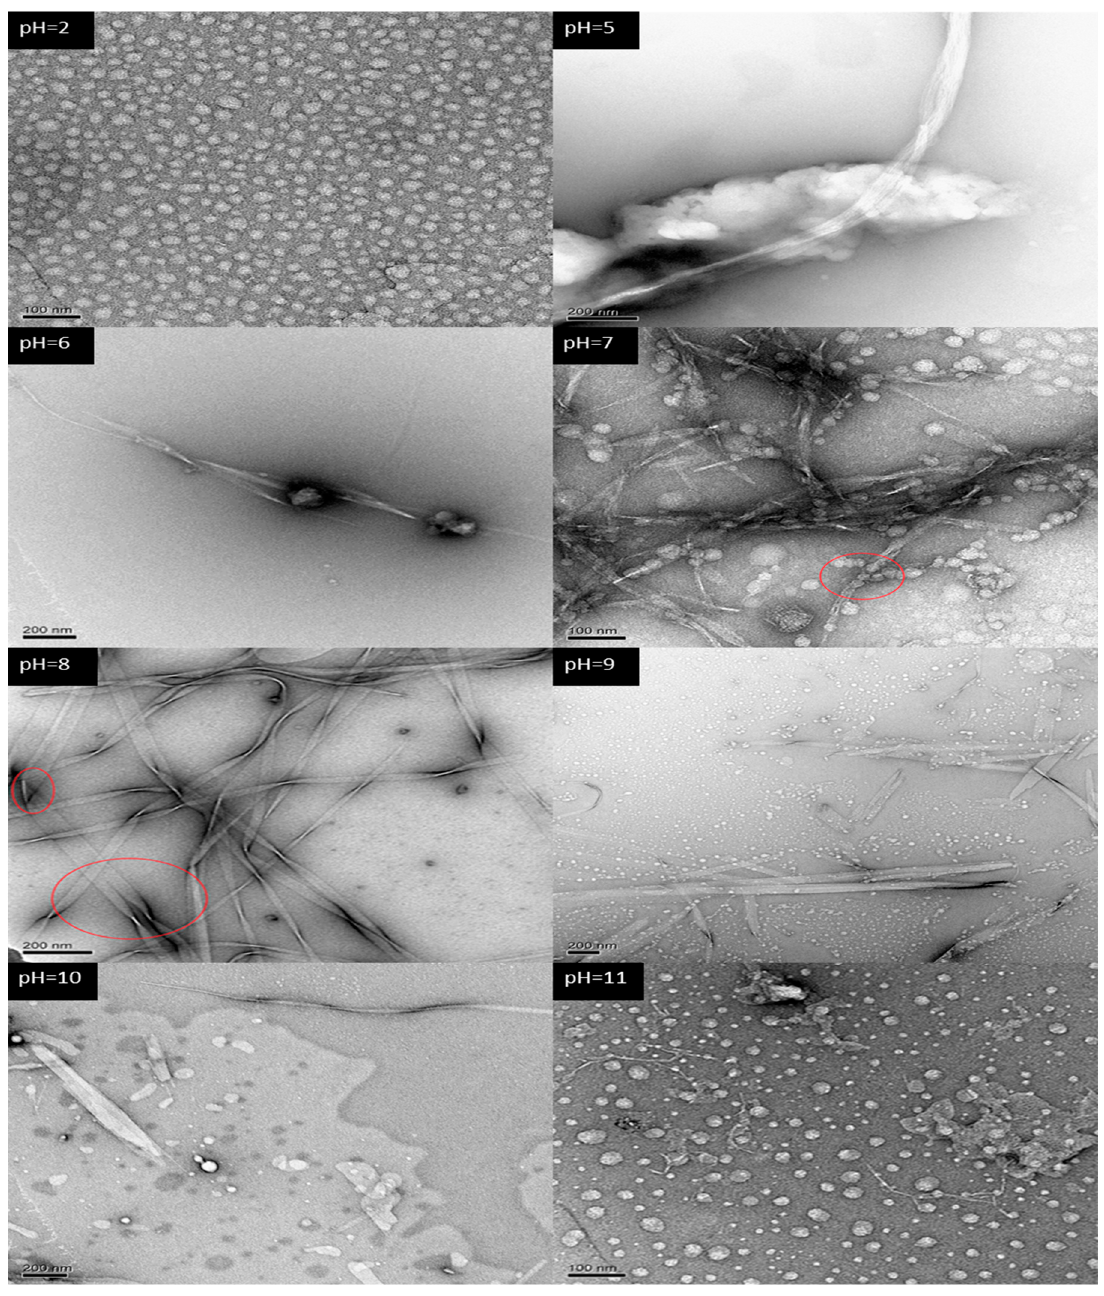
Figure 2. TEM morphologies of the self-assembled structures of A 6 K at different pH. The label in the upper left corner corresponds to different pH values.